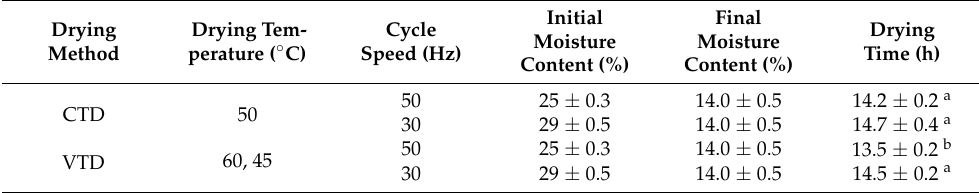
Table 5. Comparison of four hot air-drying